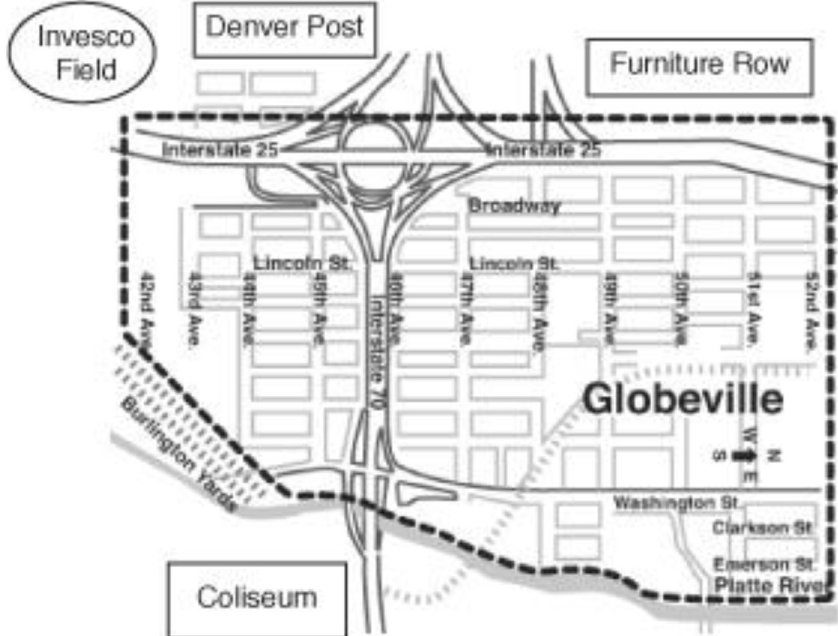
Fig. 1 Map of Globeville (Source: Denver Public Library,